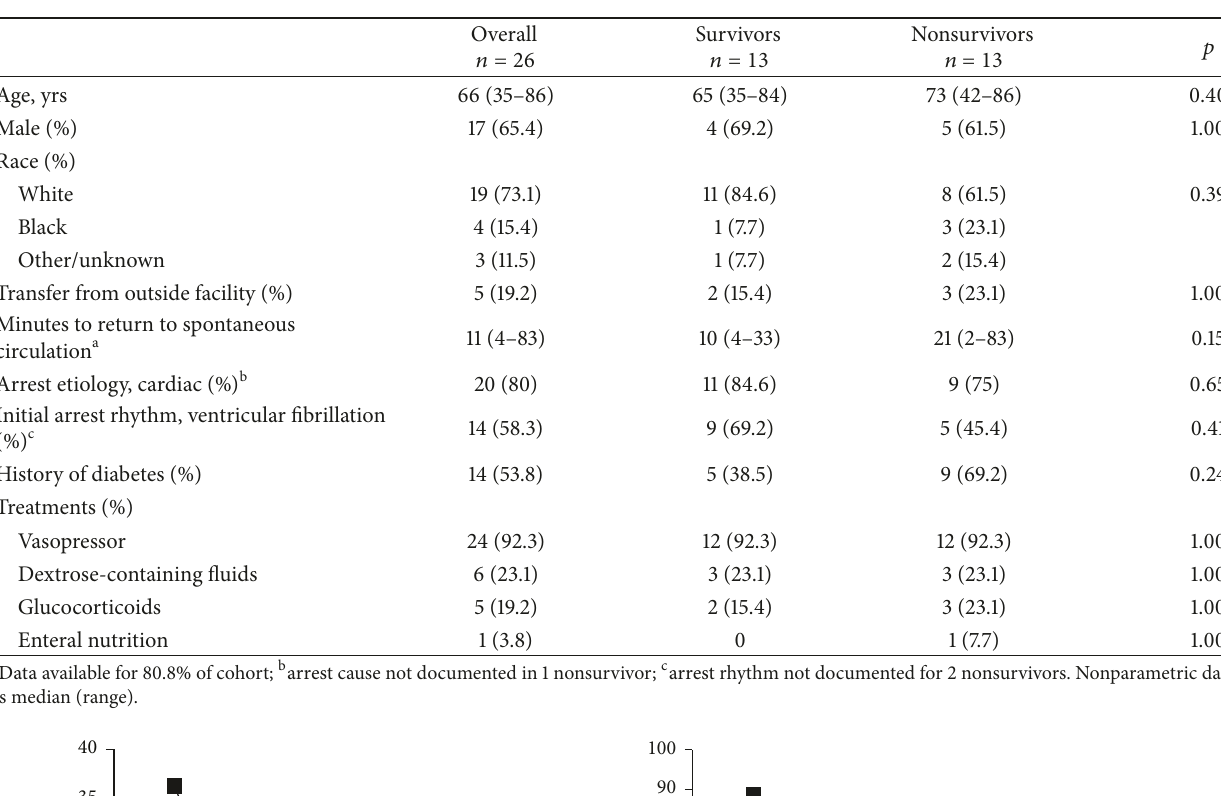
Table 1: Baseline characteristics.